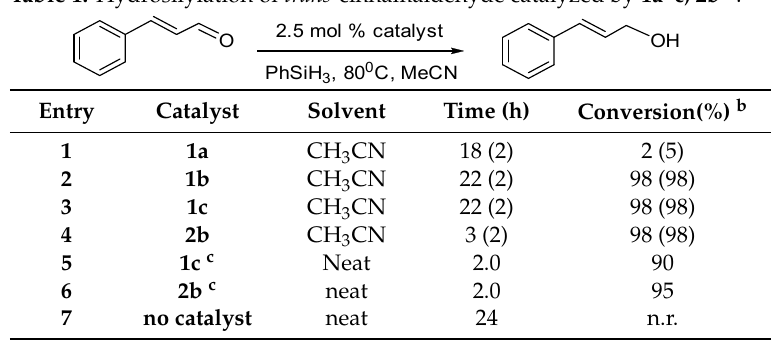
Figure 3. Thermal ellipsoid (50% probability level) plot of the solid-state structure of 2b with select atom labeling. Hydrogen atoms and the PF 6 ion are omitted for clarity. Selected bond lengths (Å):